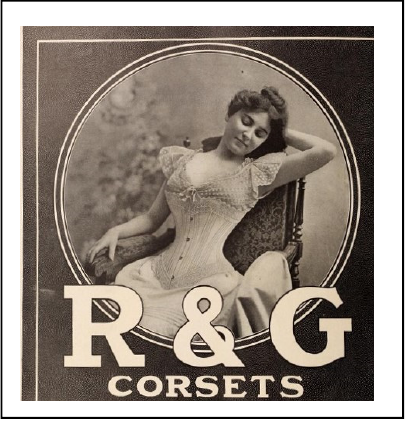
Figure 8. Bodily Perfection. Christian Herald , 4 April 1900, p. 296.